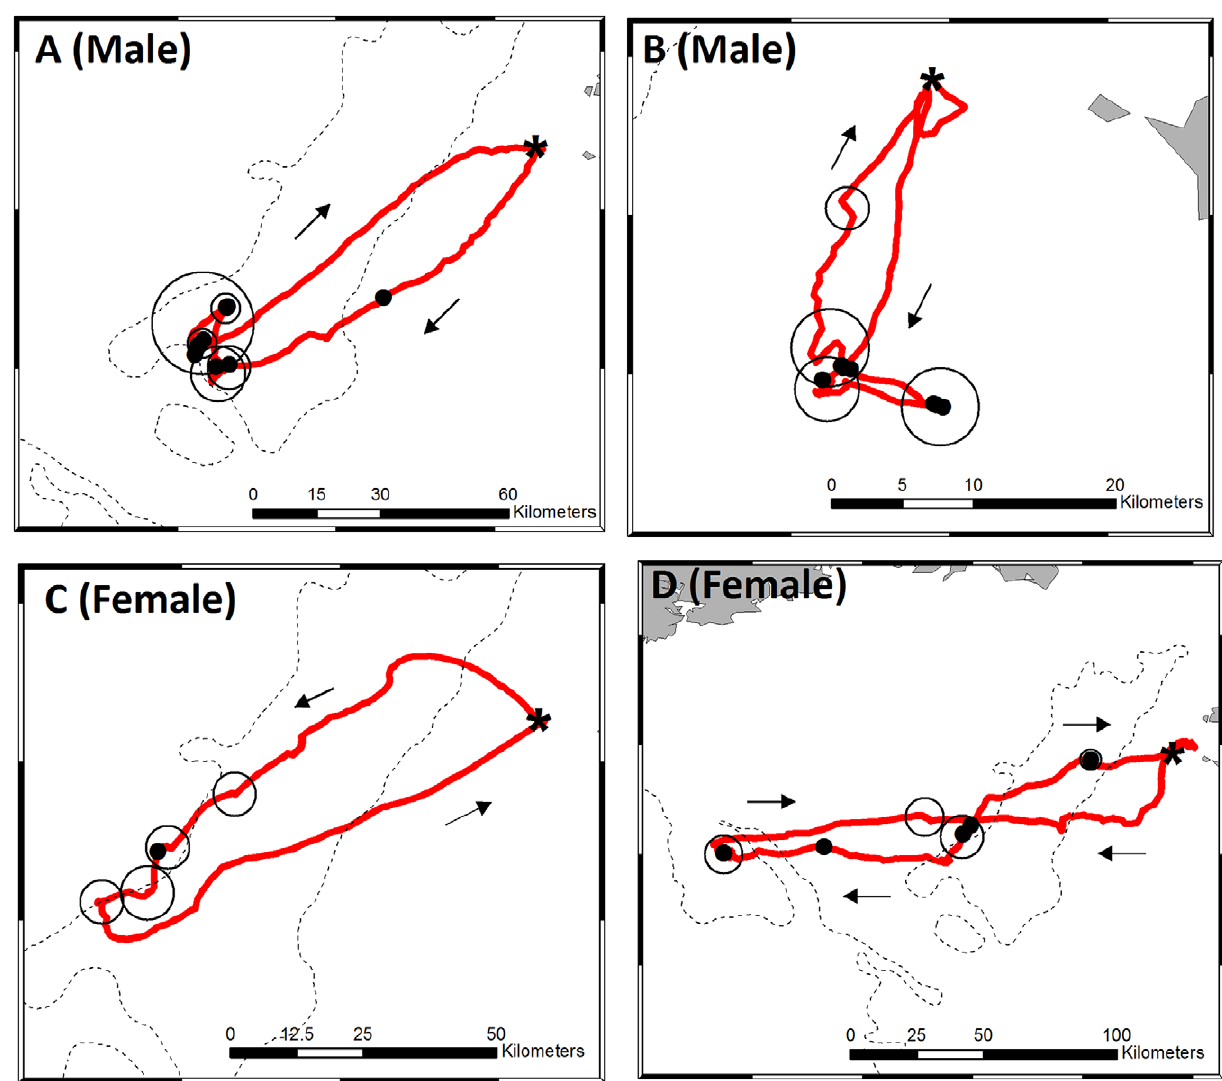
Figure 3. Bird-borne cameras and GPS reveal gannet search behaviours in relation to fishing activity. Figures show single foraging trips of four gannets reconstructed using fixes from GPS loggers. Open circles indicate location of area-restricted search (ARS) zones along the foraging track and are proportional to the scale of the ARS zone. Closed circles indicate the location of fishing vessels photographed by gannet-borne cameras. Arrows show the direction of travel and an asterix the location of the colony. Gannets showed a mixed foraging strategy, illustrated by ARS zones occurring with and without the fishing vessels. Males A & B foraged more at fishing boats compared with females C & D.